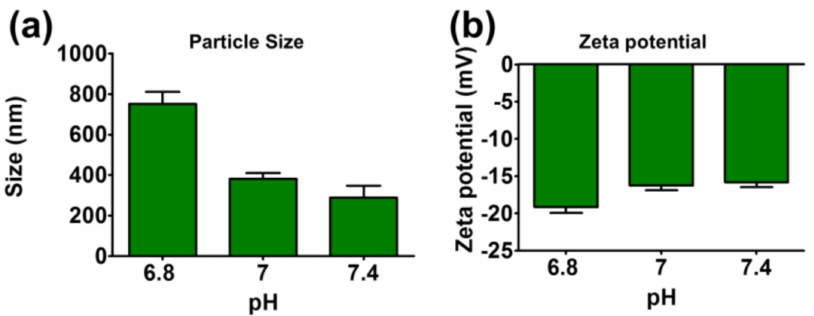
Figure 3. Influence of LF protein corona in TA-LF complexes with change in pH. ( a ) Particle size and ( b ) zeta potential of TA-LF were measured in different pH of 4-(2-hydroxyethyl)-1- piperazineethanesulfonic acid (HEPES) buffer solutions. Data presented as mean ± SEM ( n =